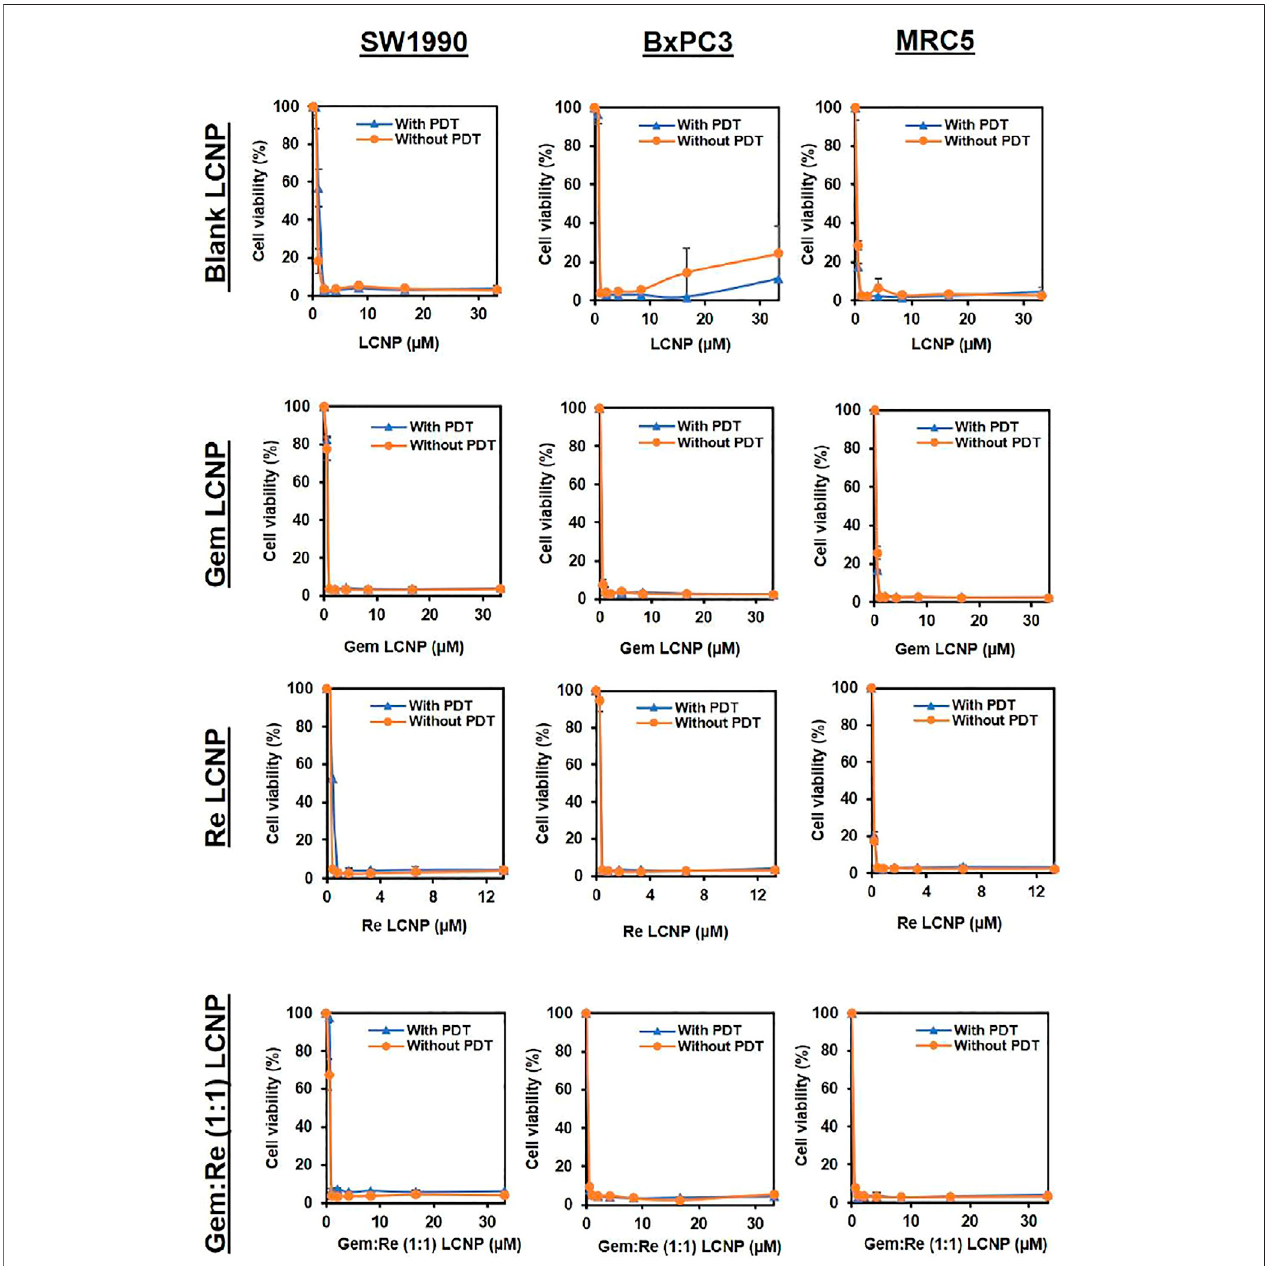
FIGURE 8 | Dose response curves of Blank LCNPs, LCNPs loaded with gemcitabine, Re(I) bisquinolinyl complex, and Gem:Re (1:1) in pancreatic cancer cells, respectively (n = 3).